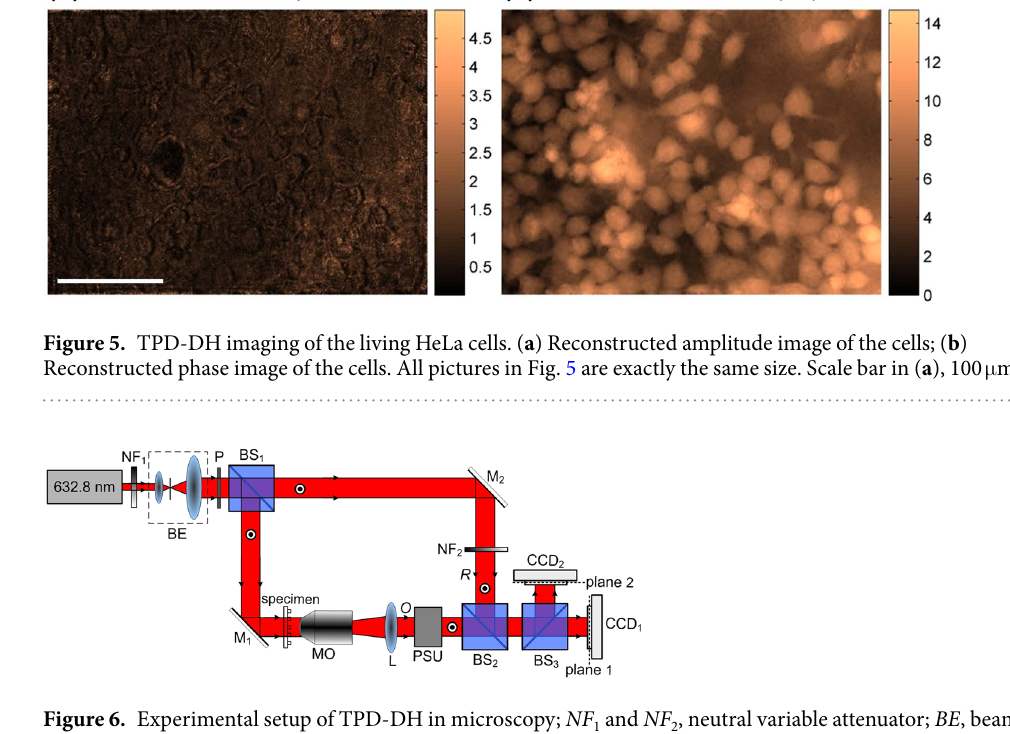
Figure 6. Experimental setup of TPD-DH in microscopy; NF 1 and NF 2 , neutral variable attenuator; BE , beam expander; BS 1 , BS 2 , BS 3 , polarization-maintaining beamsplitters; P , linear polarizer; M 1 , M 2 , mirrors; PSU , phase shifting unit; MO , microscopic objective; L , achromatic lens; CCD 1 , CCD 2 , CCD